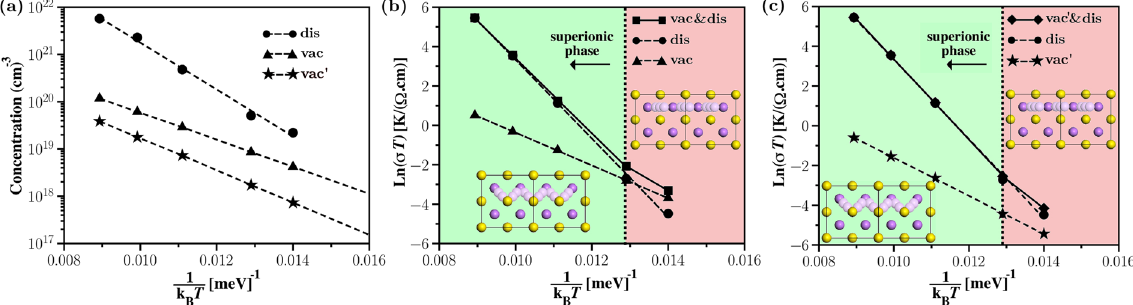
Figure 4. ( a ) Concentration of Li vacancy as function of temperature inverse calculated by eqs (1) and (2) for − 2.3 eV ≤ Δ μ ≤ − 2.0 eV (vac) and − 2.0 eV < Δ μ ≤ 0 eV (vac ′ ) as well as that of interstitial Li calculated by Li Li eq. (3) (dis). Li ion conductivities as function of temperature inverse for ( b ) vac&dis and ( c ) vac ′